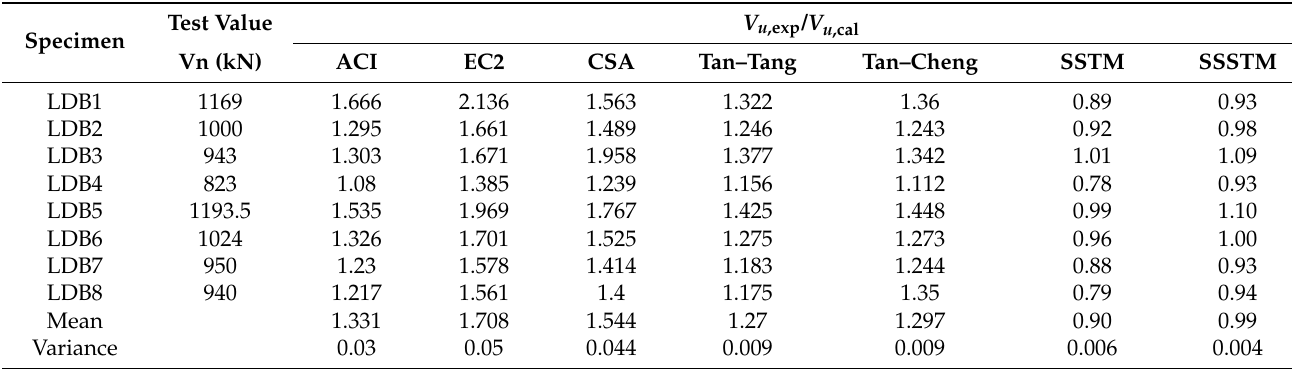
Table 5. Comparison of STM predictions and experimental